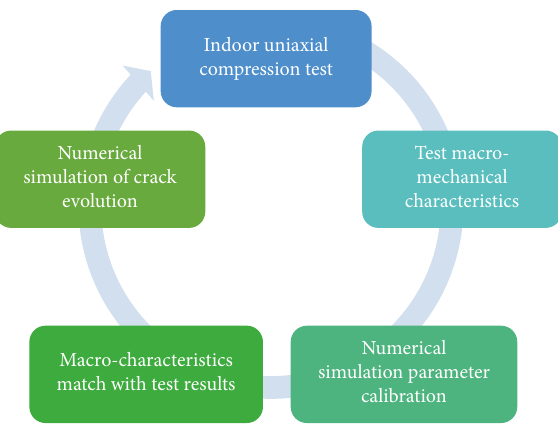
Figure 8: Calibration trial and error method. Table 2: Micromechanical parameters of the numerical